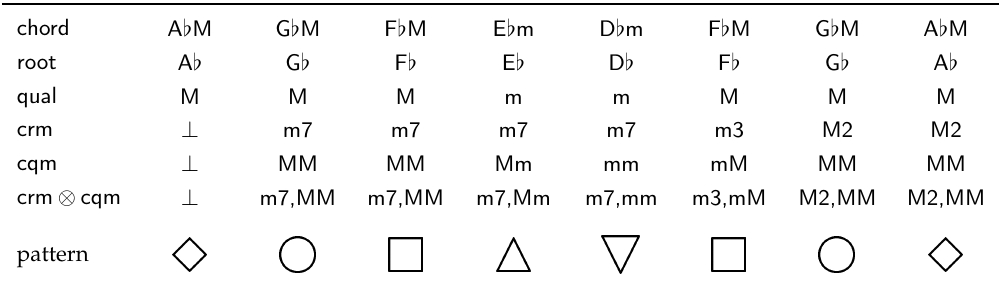
Table 1. Fragment of Overture (from Tron: Legacy, Daft Punk, 2010) showing the chord, chord root, chord quality, chord movement (root and quality) relations, and a compound attribute. At the bottom is a pattern derived from the chord sequence showing equality relations by equivalently shaped nodes. Undefined values are indicated by ⊥ .